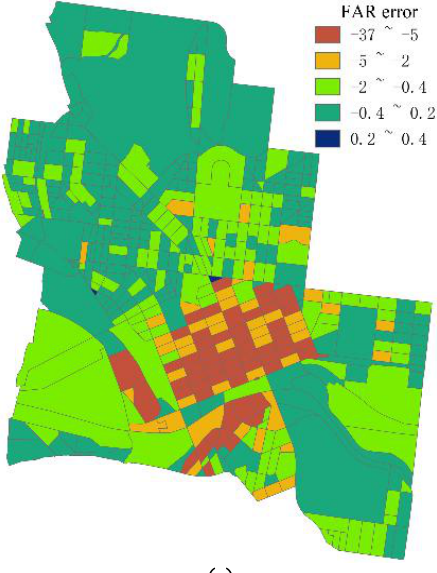
Figure 5. Block Floor Area Ratio (FAR) results. (a) Estimated FAR map. (b) True FAR map. (c) FAR error map.